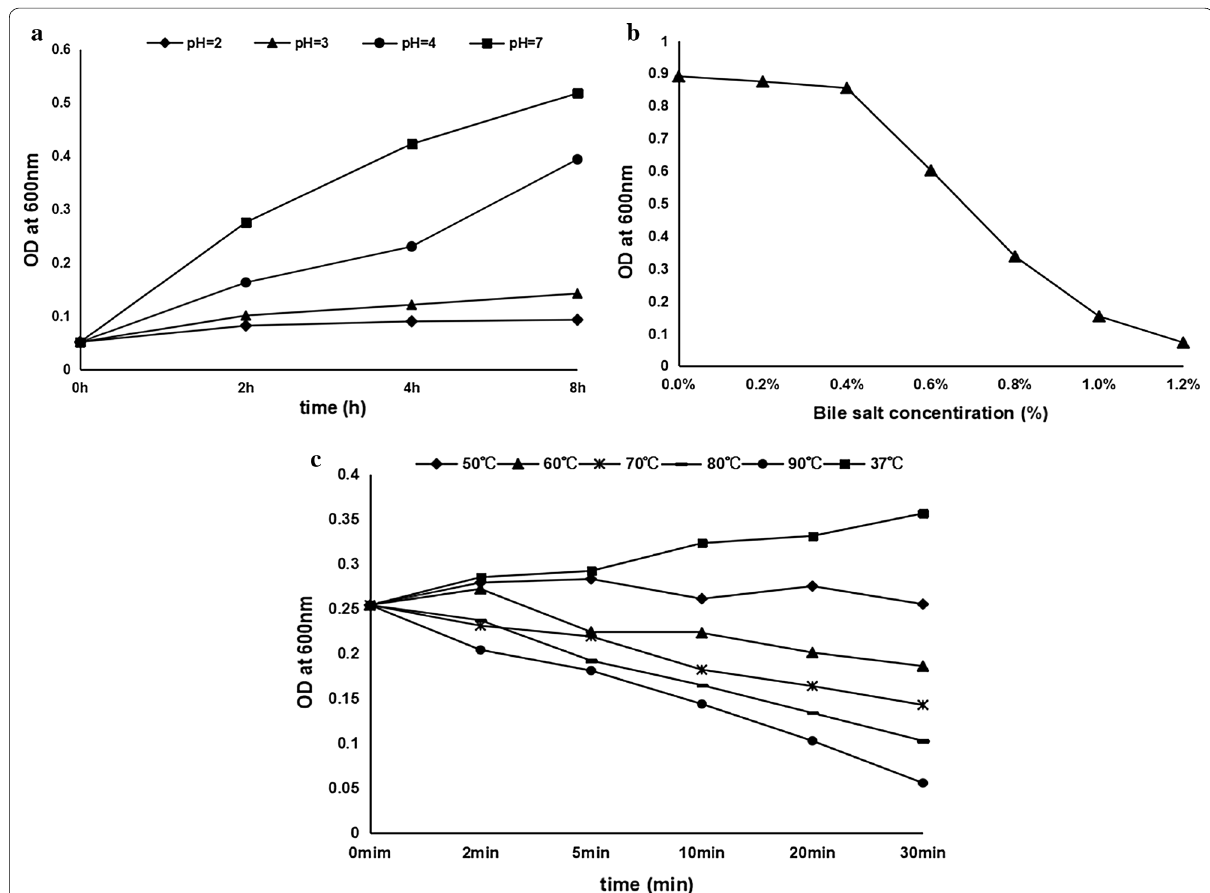
Fig. 2 Tolerance characteristics of the bacterial strain R8. a Tolerance at different pH values. b Tolerance at different concentrations of bile salt. c Tolerance at different